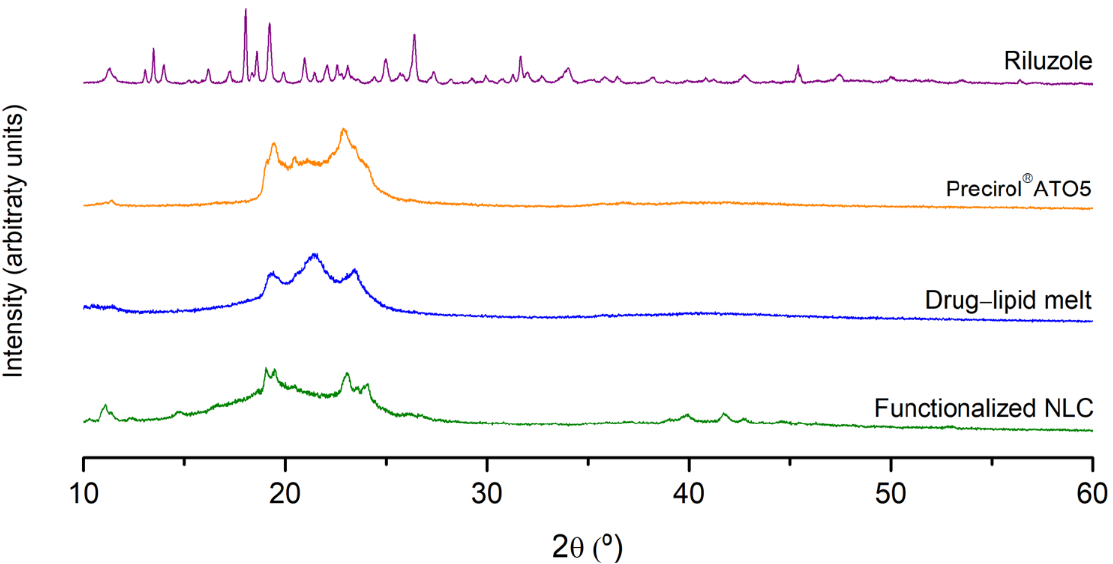
Figure 6. X-ray diffractograms of riluzole, Precirol ® ATO5, drug–lipid melt, and functionalized NLC.